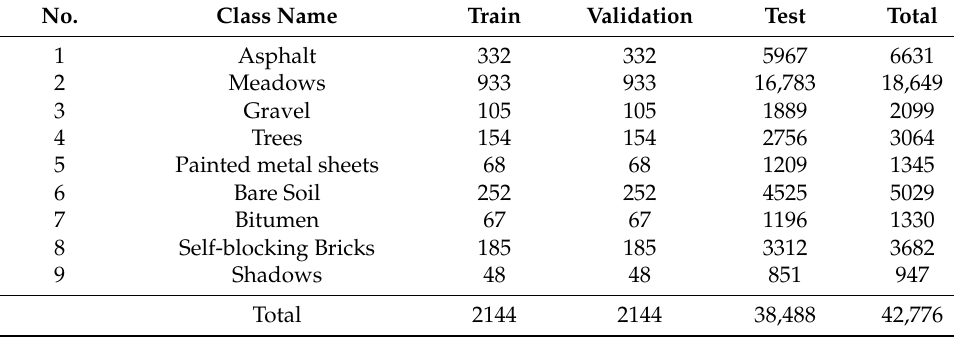
Table 3. Train, validation and test split of PU dataset.